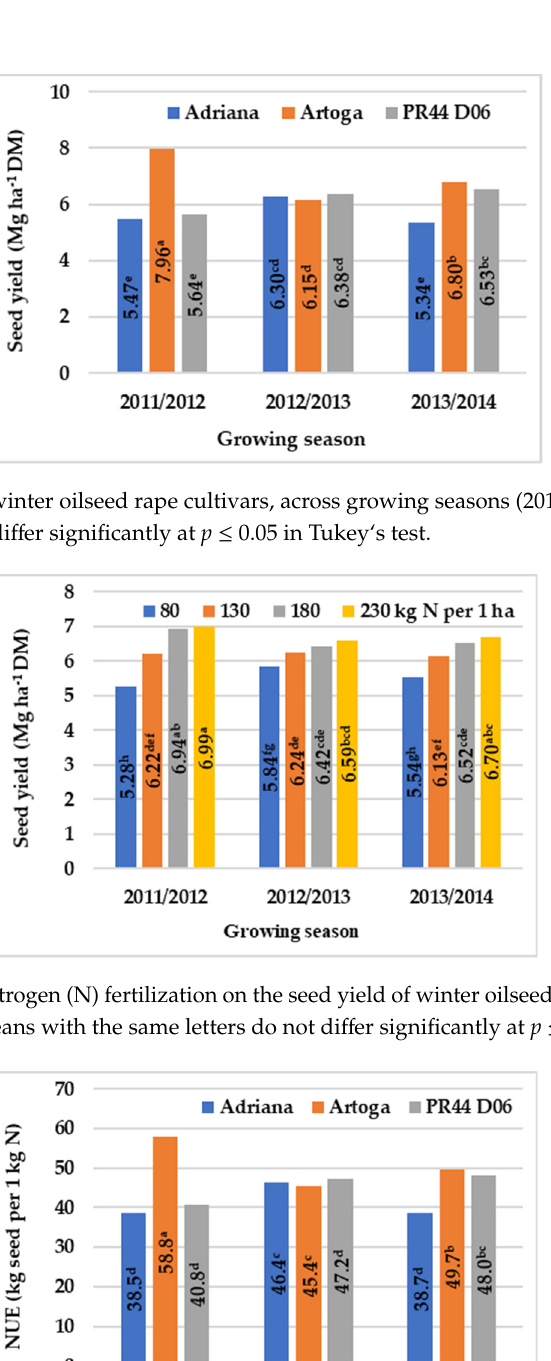
Figure 4. The effect of N rate on the nitrogen use efficiency of winter oilseed rape cultivars, across years. Means with the same letters do not differ significantly at p ≤ 0.05 in Tukey`s test. Regardless of cultivar, N rates higher than 180 kg ha −1 exerted a yield-forming effect only in combination with soil-applied S. In treatments supplied with high rates of N (180–230 kg N ha −1 ), an increase in the N rate by 1 kg without supplementary S fertilization was not productive in any of the studied cultivars (Figure 5).